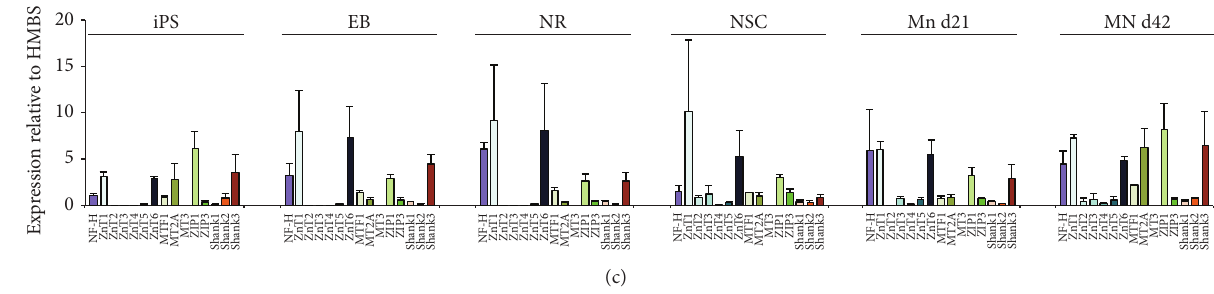
Figure 1: Expression of zinc homeostasis genes during stem cell differentiation into motor neurons. (a) Quantitative evaluation of mRNA expression levels normalized to HMBS of selected zinc homeostasis and the zinc-dependent SHANK genes. Analyses were performed in triplicate ( 𝑛 = 3 ) and the mean normalized expression is shown. Neurofilament H (NEFH) expression was used to control successful differentiationandincreasessignificantlyinNRsandrisesagainafterasignificantdecreaseinNSCinsuspension(iPSCversusNR: 𝑝 = 0.0028 ; NR versus NSC: 𝑝 = 0.0175 ). Several zinc transporters show developmental stage-dependent expression as well as altered expression levels during differentiation. Expression of ZnT1 is significantly increased in motor neurons at d42 compared to the iPS cell stage ( 𝑝 = 0.0086 ). ZnT2 expression in turn was only detected above background in NSC. Expression of ZnT3 is very low in early stages (iPS, EB, and NR) but increases in NSC and becomes significant in motor neurons (iPSC versus MN d21: 𝑝 = 0.0239 ) in which ZnT3 levels remain elevated. No expression of ZnT4 was detected in iPS cells, but mRNA levels gradually increase from EB to motor neurons (EB versus MN d42: 𝑝 = 0.0352 ; NR versus MN d21: 𝑝 = 0.0384 ). This is also observed for ZnT5 expression; however it is only seen as trend. Additionally, the expression of ZnT6 was found to be significantly higher in motor neurons compared to iPS cells (iPS versus MN d42: 𝑝 = 0.0178 ). Along with the increase in expression of some zinc transporters during motor neuron differentiation, the mRNA levels of MTF1 are significantly higher in motor neurons compared to iPS cells (iPSC versus MN d42: 𝑝 = 0.0074 ; NSC versus MN d42: 𝑝 = 0.0170 ; MN d21 versus MN d42: 𝑝 = 0.0263 ). While ZIP1 and ZIP3 are expressed on similar level through all stages of motor neuron differentiation, the expression of MT2A shows some variance in iPSC but otherwise is significantly higher in motor neurons compared to most previous stages and significantly increases in motor neurons between d21 and d42 (EB versus MN d42: 𝑝 = 0.0347 ; NSC versus MN d42: 𝑝 = 0.0474 ; MN d21 versus MN d42: 𝑝 = 0.0397 ). The expression of MT3 in turn could only be detected in NSC and motor neurons but not in earlier stages. Although SHANK proteins are associated with synapses that only occur in motor neurons, their expression can be already detected in iPS cells and later stages of motor neuron differentiation. SHANK1 and SHANK2 expression increases towards later stages (SHANK1: iPSC versus NR: 𝑝 = 0.0225 ; iPSC versus MN d21: 𝑝 = 0.0327 ) (SHANK2: EB versus MN d42: 𝑝 = 0.0061 ; NR versus MN d42: 𝑝 = 0.0132 ; MN d21 versus MN d42: 𝑝 = 0.0017 ), although the expression of SHANK2 in iPS cells shows high variability. SHANK3 is expressed on similar level throughout differentiation. (b) Representative images of hiPSC undergoing differentiation to motor neurons (MN) via the generation of embryoid bodies (EB), neural rosettes (NR), and neural stem cells (NSC). (c) Comparison of mRNA expression levels across different zinc homeostasis genes. In general, expression levels of ZnT1 and ZnT6 were the highest compared to other ZnTs across all developmental stages. Similarly, ZIP1 expression was high throughout all phases of motor neuron differentiation, while MTF1 and MT2A expression increased in old motor neurons. ∗ 𝑝 ≤ 0.05 ; ∗∗ 𝑝 ≤ 0.01